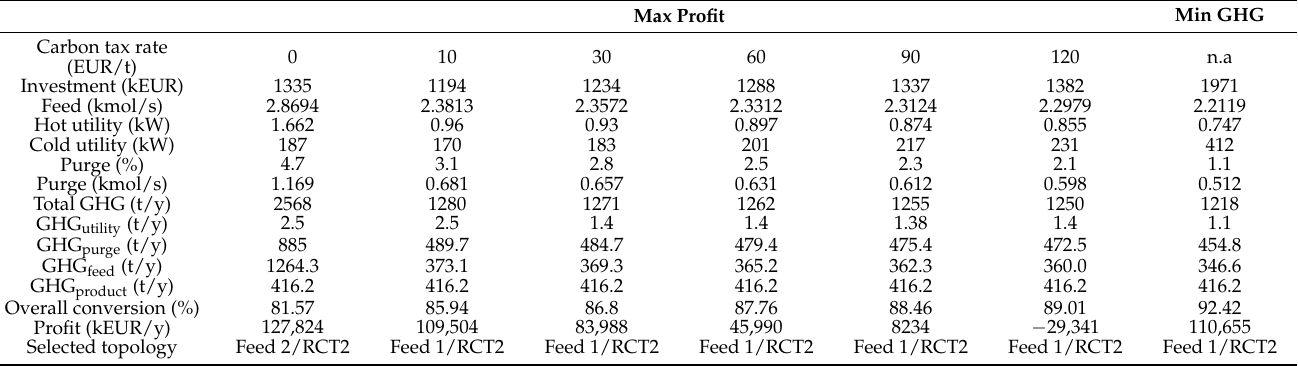
Table 2. Results of the synthesis of heat-integrated